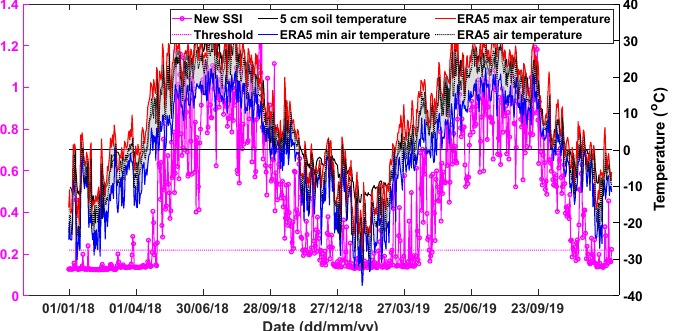
Figure 11. Time series of the SSI new , threshold of SSI new, in situ soil and ERA5-land air temperature data at site MB3 over the RISMA area.